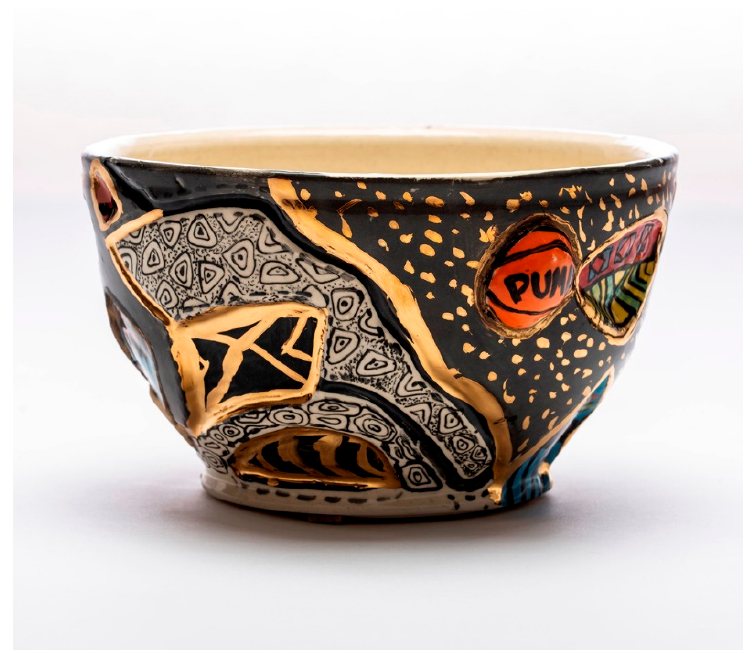
Figure 7. Stunting: Pump I, 2018 , Porcelain, china paint, luster, 5 × 10 × 10 in. Image by KeneK Photography, courtesy of Wexler Gallery.